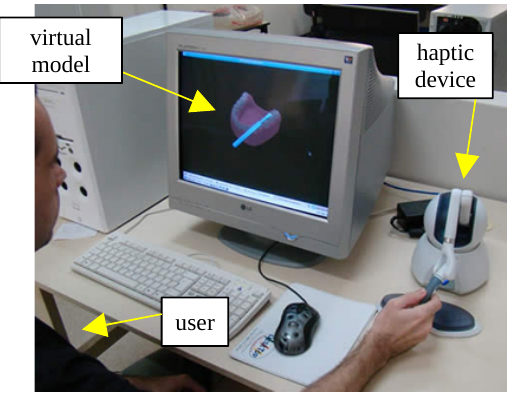
Fig. 5. User interacting with the game